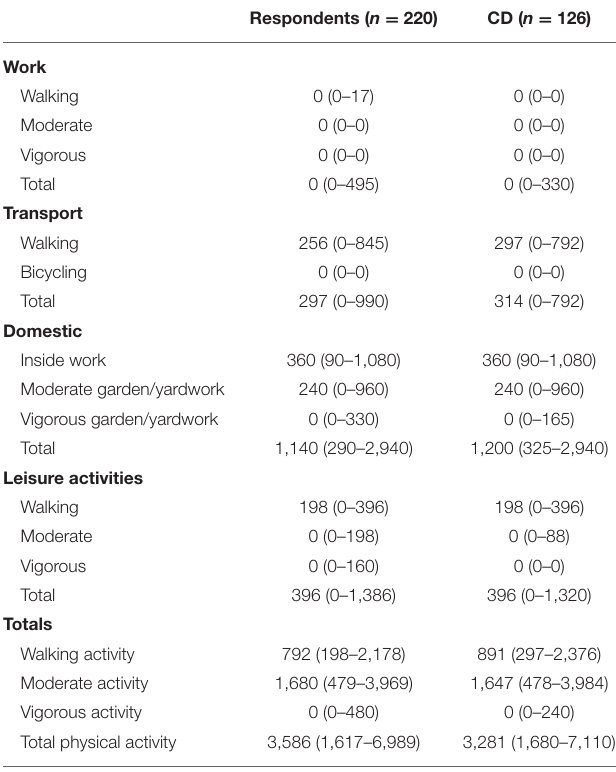
TABLE 1 | IPAQ activity scores for each domain and the total across all domains. TABLE 2 | Total self-reported daily time spent in walking, moderate and vigorous activities and in sedentary behavior across all